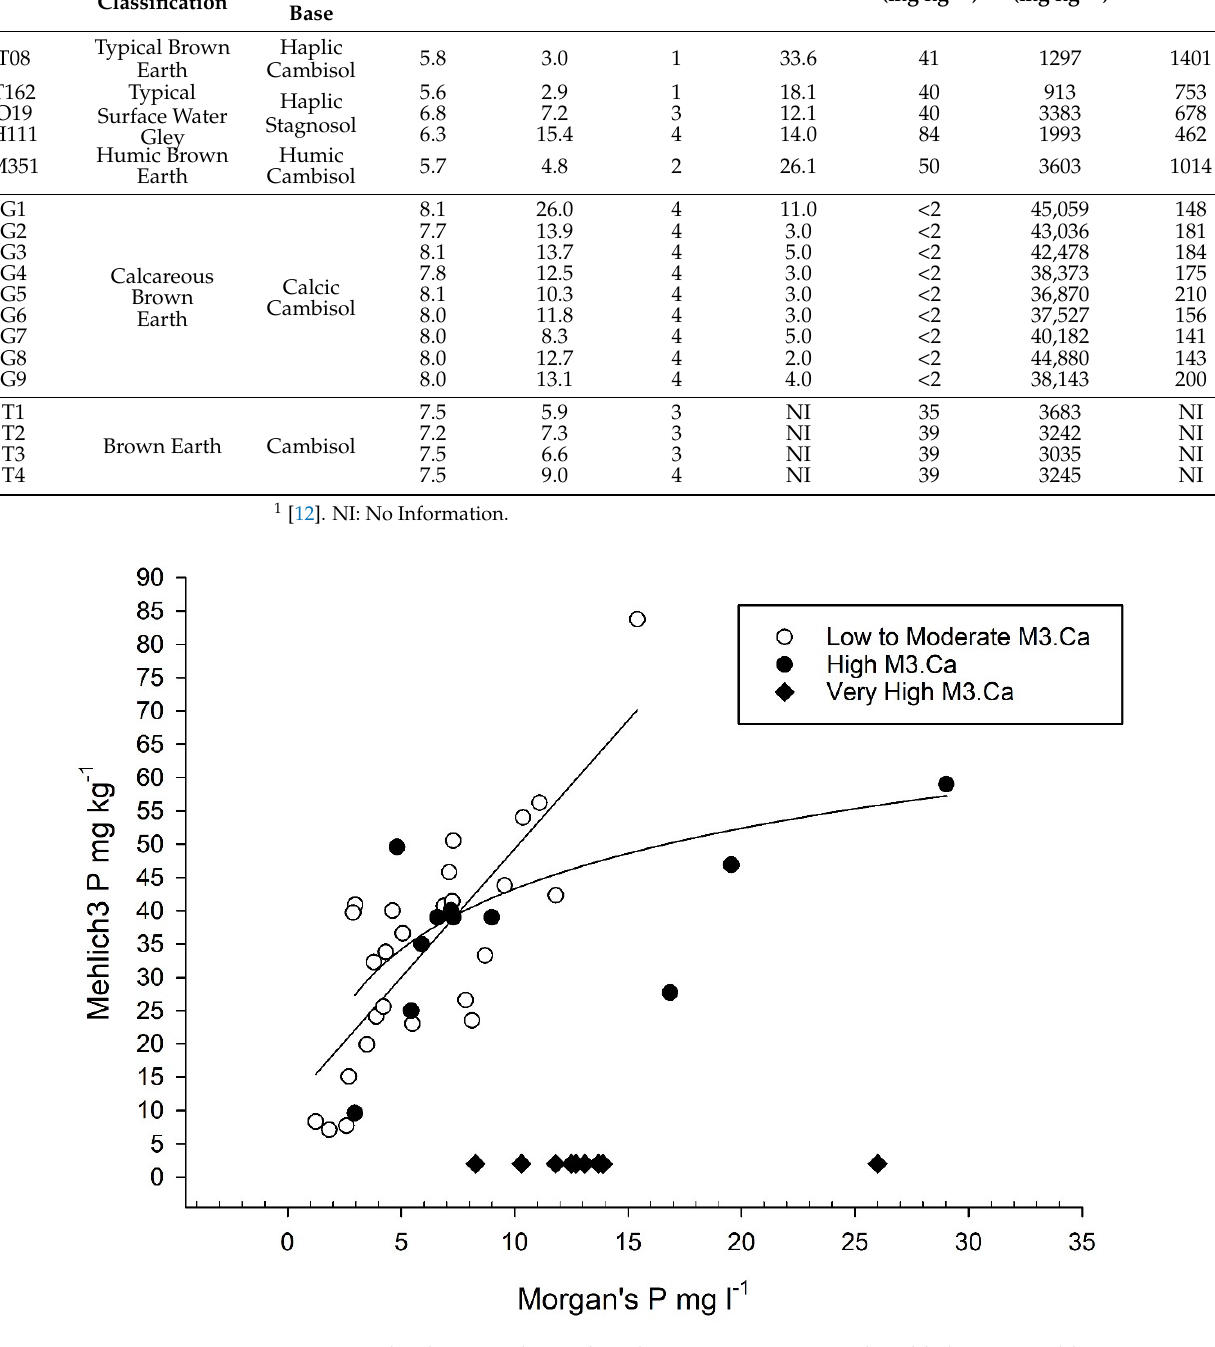
Figure 3. The diverse relationships between Morgan’s and Mehlich3 extractable P across 47 sites based on soil Ca values, categorised as low to moderate M3-Ca (<2000 mg kg − 1 ), high M3-Ca (<2000 mg kg − 1 ) and very high M3-Ca (>20,000 mg kg − 1 ) and illustrating the overestimation of available P as Ca increased. Regression lines plotted illustrate the linear relationship between both tests for low to moderate M3-Ca soils, and the non-linear relationship in high M3-Ca soils.